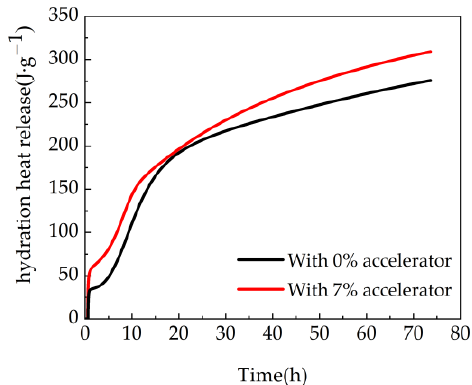
Figure 9. The hydration heat release of cement.